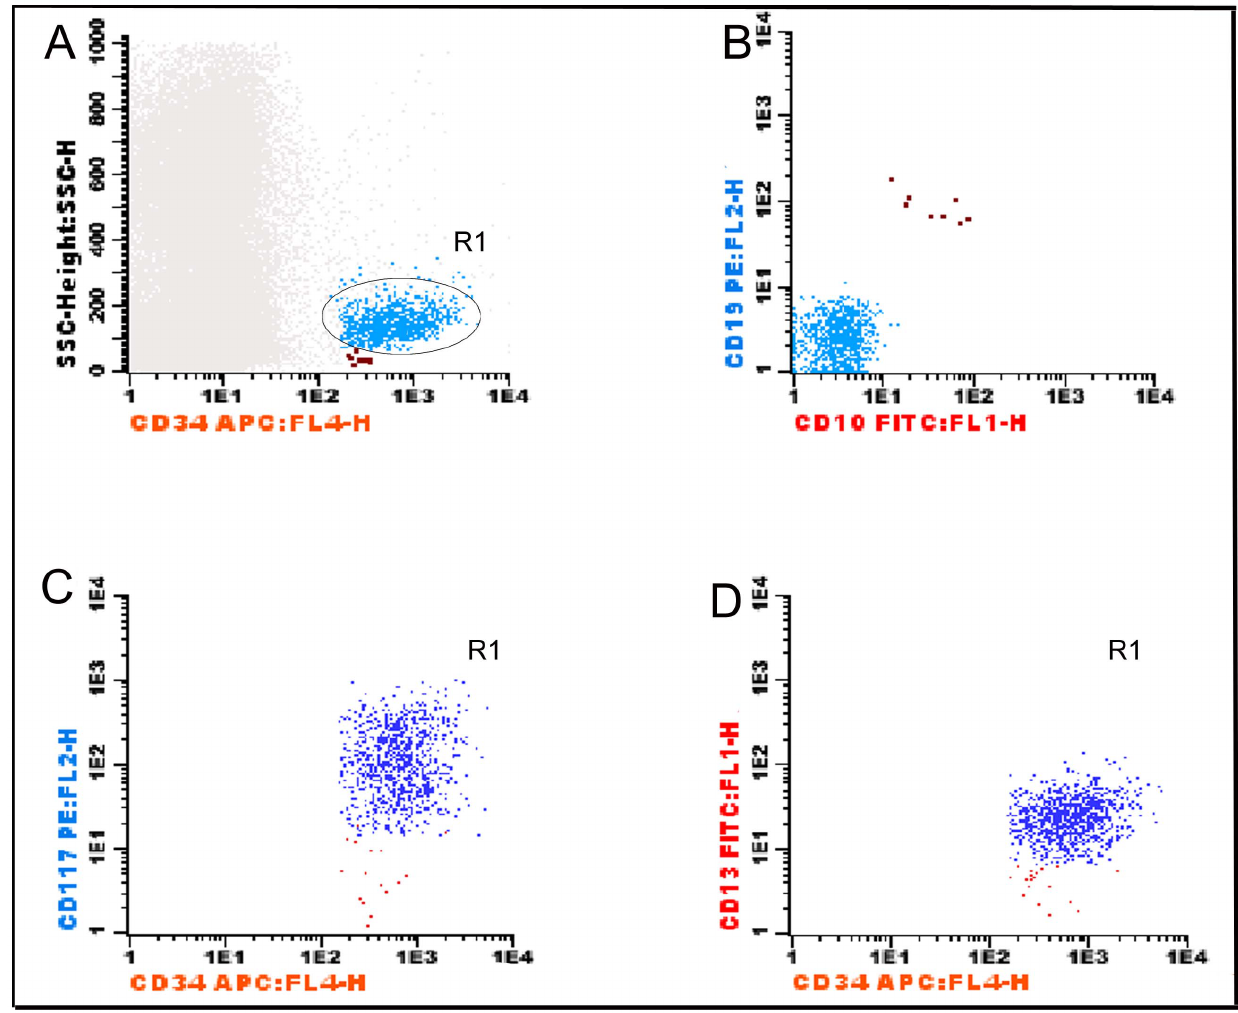
Figure 3. analysis of the subsets of CD34 + cells. (combination CD19/CD10/CD45/CD34 in A and B and CD13/CD117/CD45/CD34 in C and D). In a first step, (A) all CD34 + cells were selected in the SSC/CD34 plot. Two populations can be observed: SSC low (in brown) that are CD19 + /CD10 + (B-cell precursors) on the CD19/CD10 plot (B), and SSC int /CD34 + /CD19 2 (light blue). These cells are characterized as myeloid subsets of CD34 + cells (C and D) when analysed in the CD13/CD117/CD45/CD34 combination. Among SSC int /CD34 + cells, the CD34 + /CD117 + subset (dark blue) and CD34 + /CD117 2 subset (red) were defined by their expression of CD117 and CD13. Myeloblasts SSC int /CD34 + /CD117 + /CD13 + (dark blue) and immature cells SSC int / CD34 + /CD117 2 / CD13 2 (red).